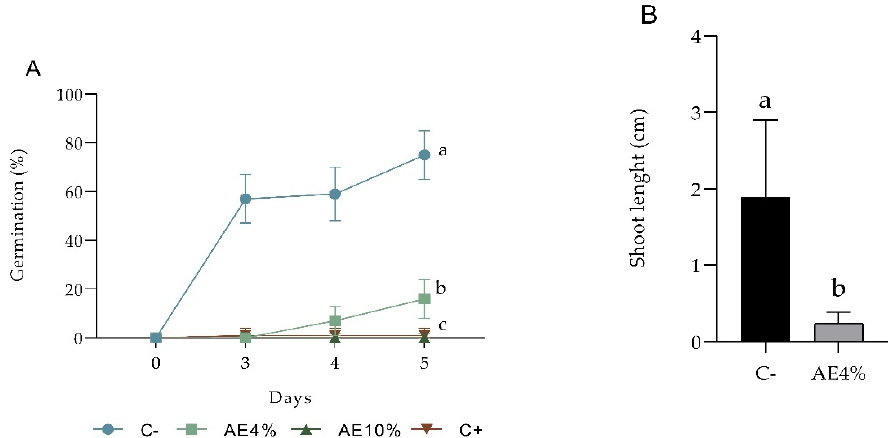
Figure 2. Pre-emergence bioassay in barnyardgrass. ( A ) Seed germination in distilled water (C-), aqueous extract (AE) at 4%, AE at 10% and NaCl (C+) and ( B ) seedling growth (shoot length) at the end of 5 days in treatments that showed germination. In ( A ), bars show 95% confidence intervals (Wilson score interval). Treatments not sharing the same letter at the final sampling time differ in germinability ( p ≤ 0.05). In ( B ), bars represent the mean ± SD. Treatments are significantly different by t -test ( p ≤ 0.05).